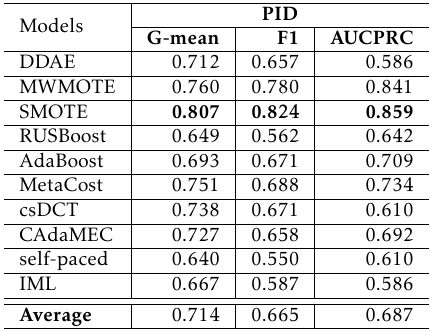
Table 18. Overall Results for Cm1